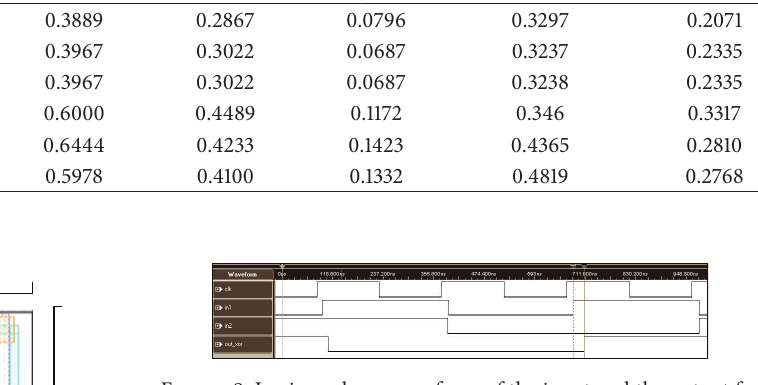
Figure 9: Logic analyzer waveform of the input and the output for the fabricated novel CMOS pass-transistor-based full-swing XOR gate.